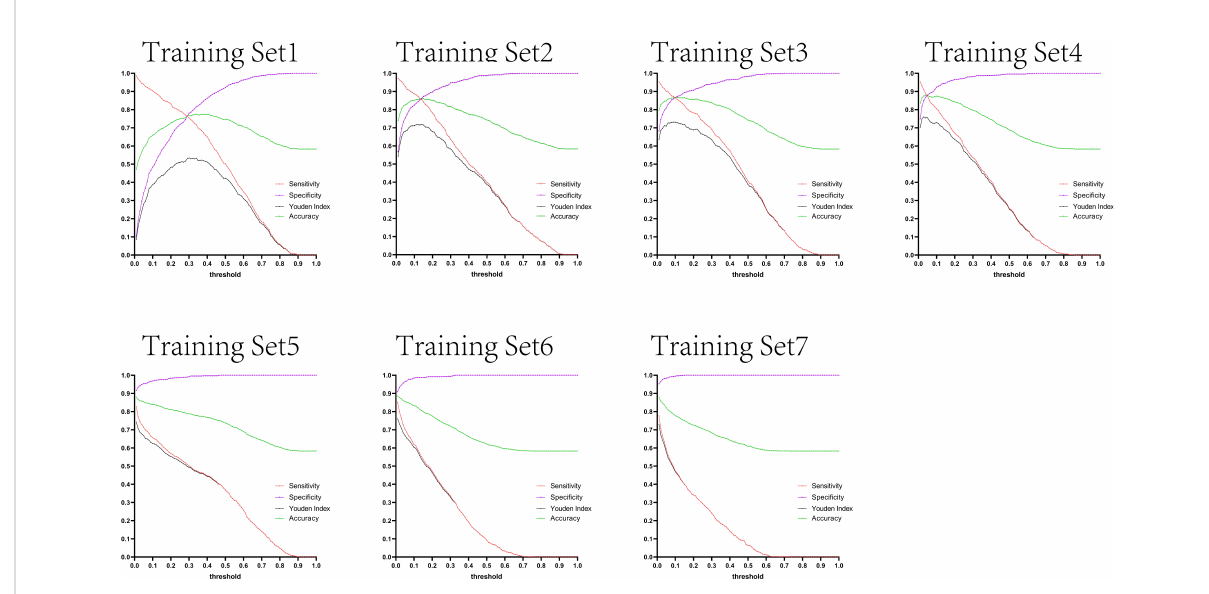
FIGURE 12 Curves of sensitivity, speci fi city, Youden index, and accuracy with threshold after test set 3 was tested separately by seven training set models.